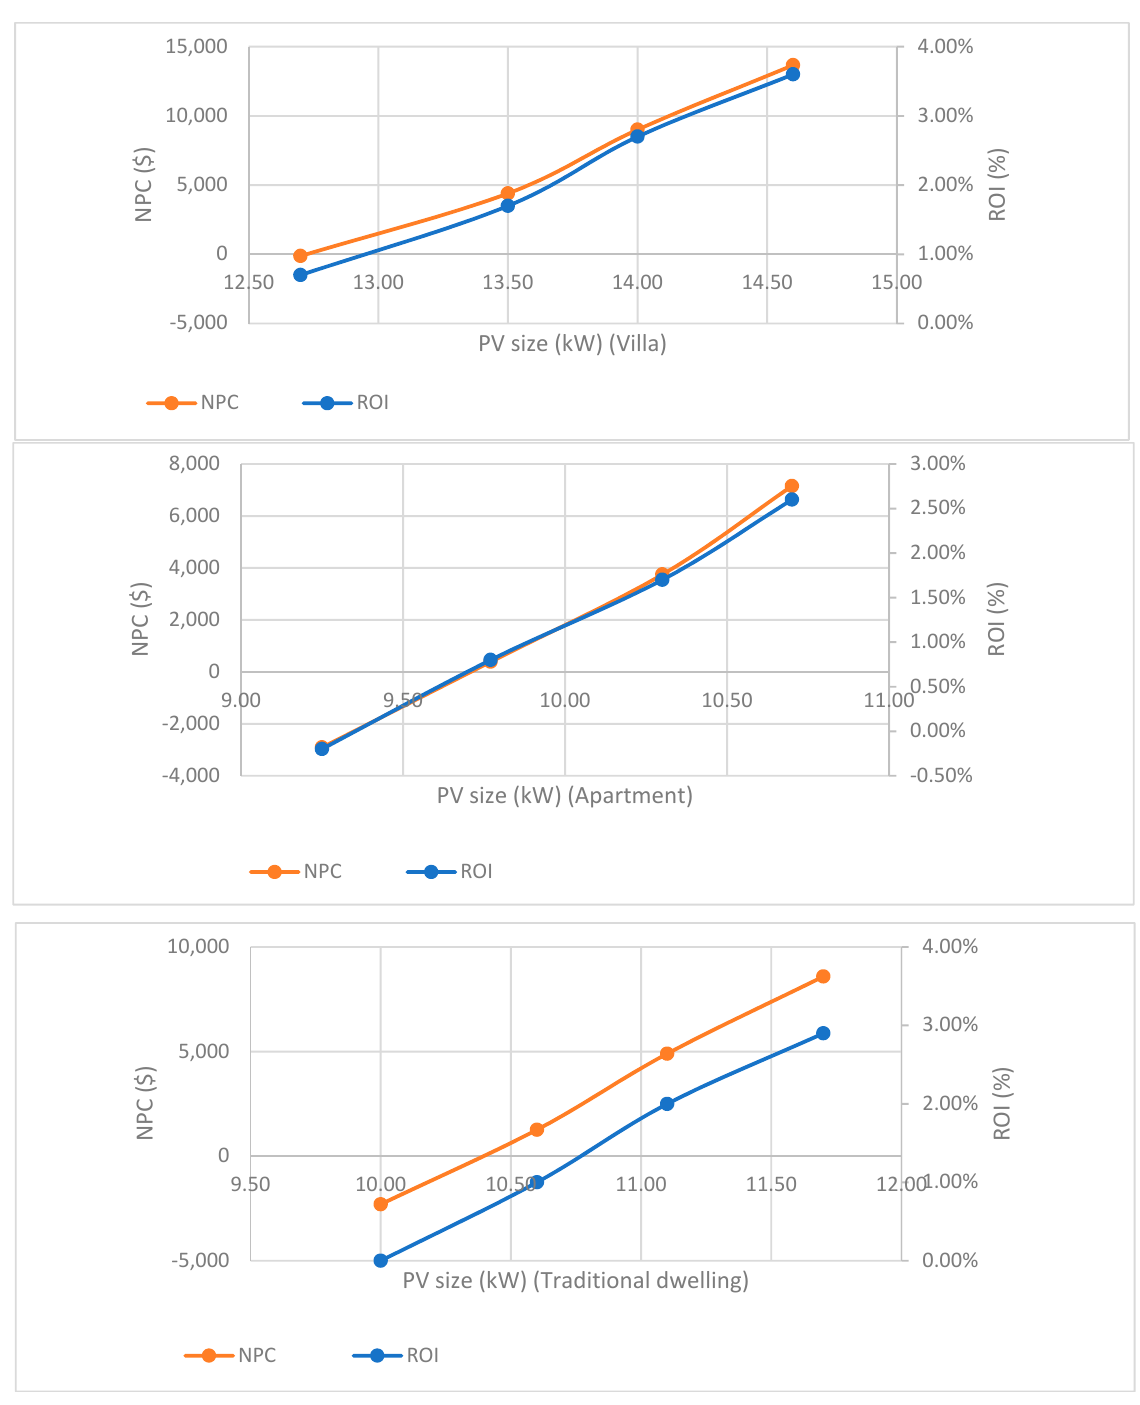
Figure 6. Comparison of NPC and ROI with capacity of PV for villa, traditional dwelling, and apartment.